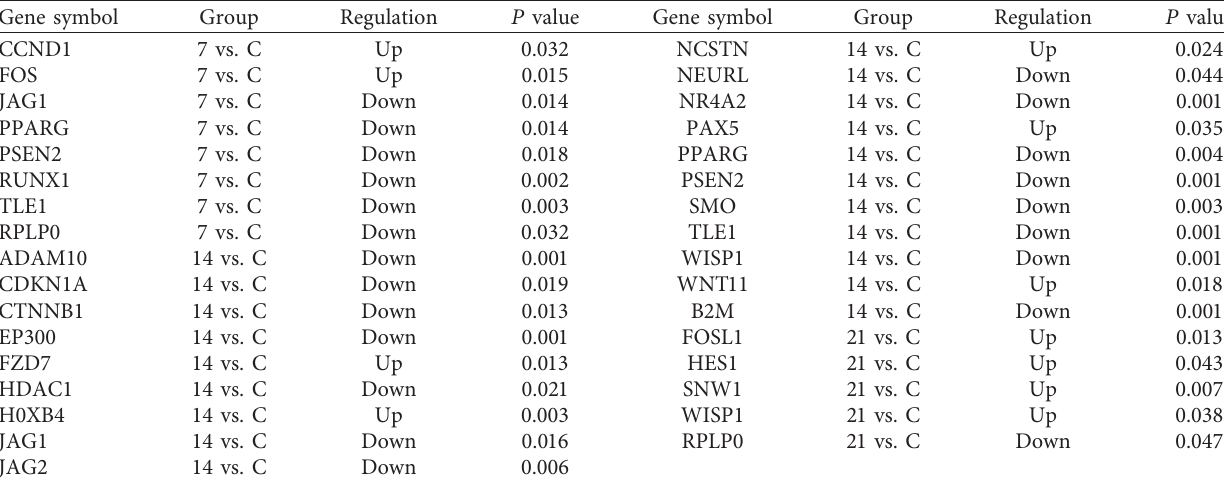
Table 2: Notch pathway qPCR results during DA neuronal